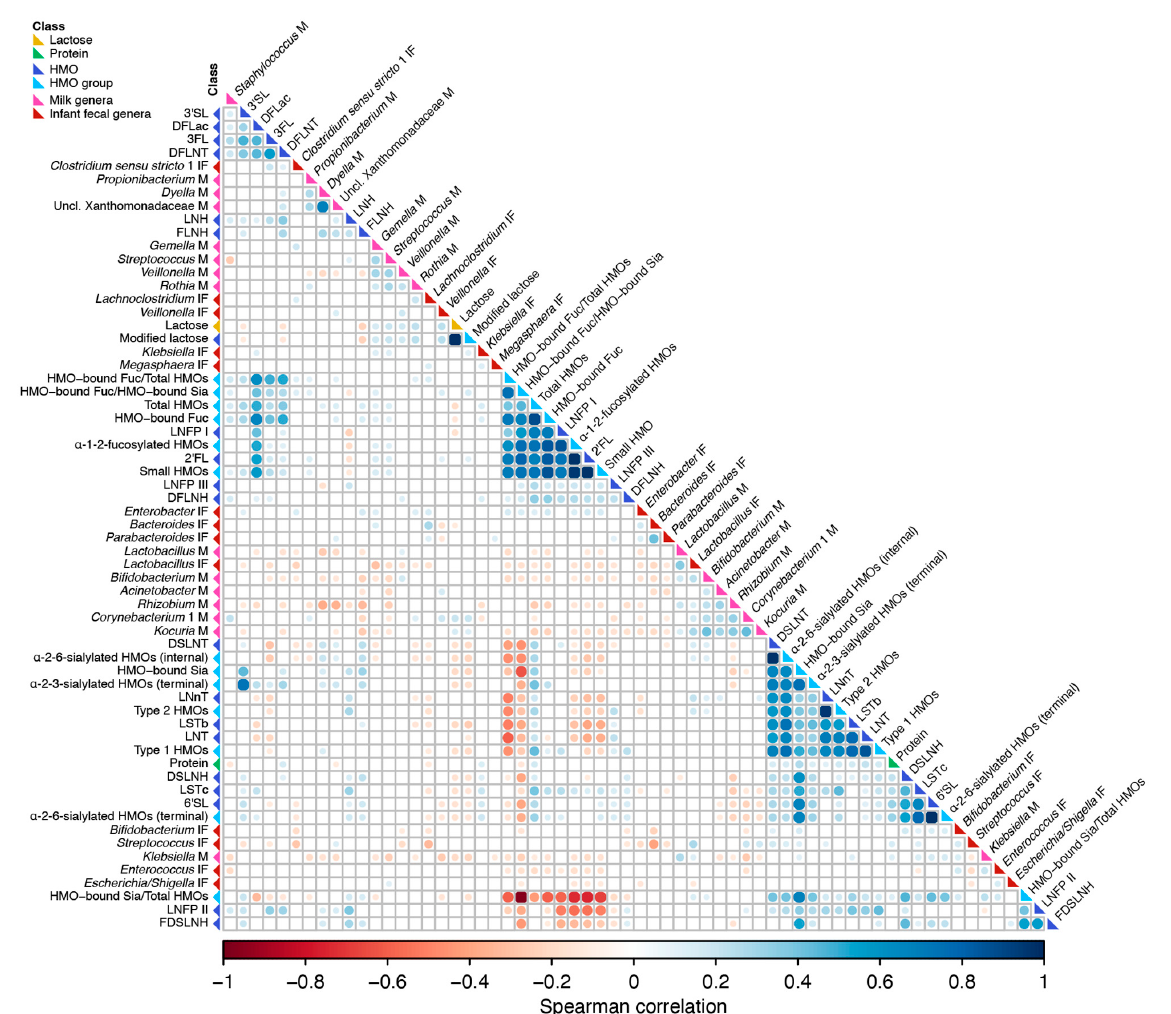
Figure 4. Correlations among microbial taxa and milk factors. Spearman rank correlations among milk (M) and infant fecal (IF) microbial taxa, lactose, protein, HMOs, and HMO groupings are shown ( n = 340 paired dyads). Only correlations with FDR p ≤ 0.1 are shown. The size of the circle represents the magnitude of the correlation, and the color represents the direction of the correlation: red (negative) and blue (positive). Features were hierarchically clustered based on Spearman correlations. Feature classes are denoted by the colored squares next to the feature name on the left, as follows: light blue, individual HMOs; dark blue, HMO groupings; light green, lactose; dark green, protein; milk genera, pink; infant fecal genera, purple. 2 (cid:48) -fucosyllactose (2 (cid:48) FL), 3-fucosyllactose (3FL), lacto-N-neotetraose (LNnT), 3 (cid:48) -sialyllactose (3 (cid:48) SL), difucosyllactose (DFlac), 6 (cid:48) -sialyllactose (6 (cid:48) SL), lacto-N-tetraose (LNT), lacto-N-fucopentaose (LNFP) I, LNFP II, LNFP III, sialyl-LNT (LST) b, LSTc, difucosyllacto-LNT (DFLNT), lacto-N-hexaose (LNH), disialyllacto-N-tetraose (DSLNT), fucosyllacto-N-hexaose (FLNH), difucosyllacto-N-hexaose (DFLNH), fucodisialyllacto-lacto-N-hexaose (FDSLNH) and disialyllacto-N-hexaose (DSLNH); small HMOs (2 (cid:48) FL, 3FL, 3 (cid:48) SL, 6 (cid:48) SL, and DFLac), modified lactose (small HMOs and lactose), type 1 HMOs (LNT, LNFP I, LNFP II, LSTb, and DSLNT), type 2 HMOs (LNnT, LNFP III, and LSTc), α